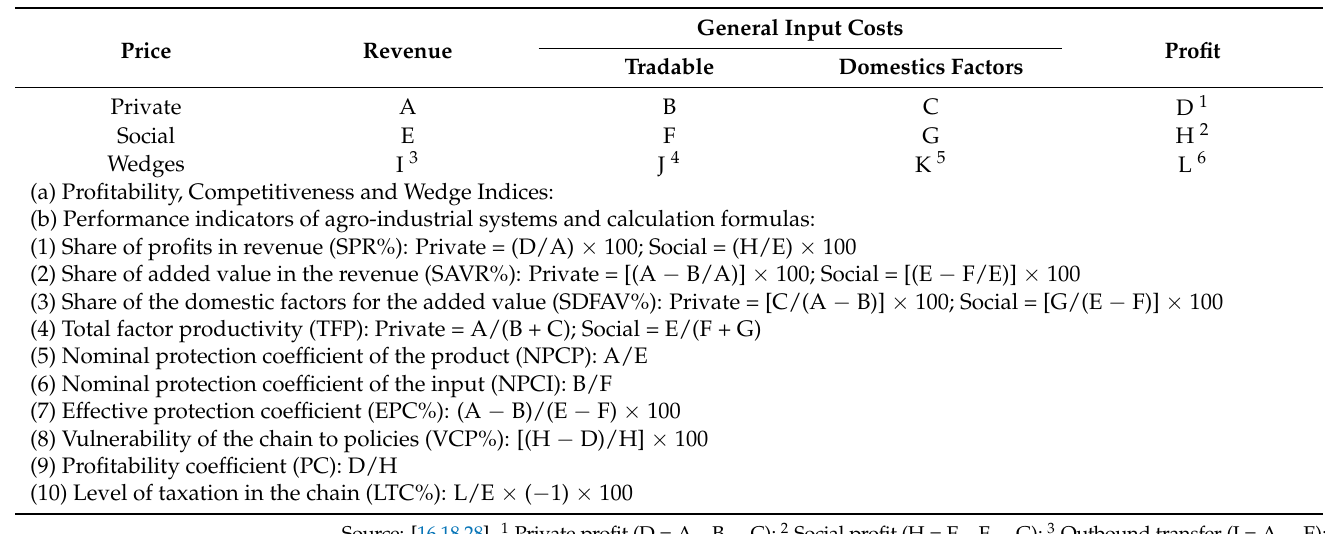
Table 1. Accounting structure of the policy analysis matrix and formulas for calculating profitability indices, competitiveness indicators and policy effect